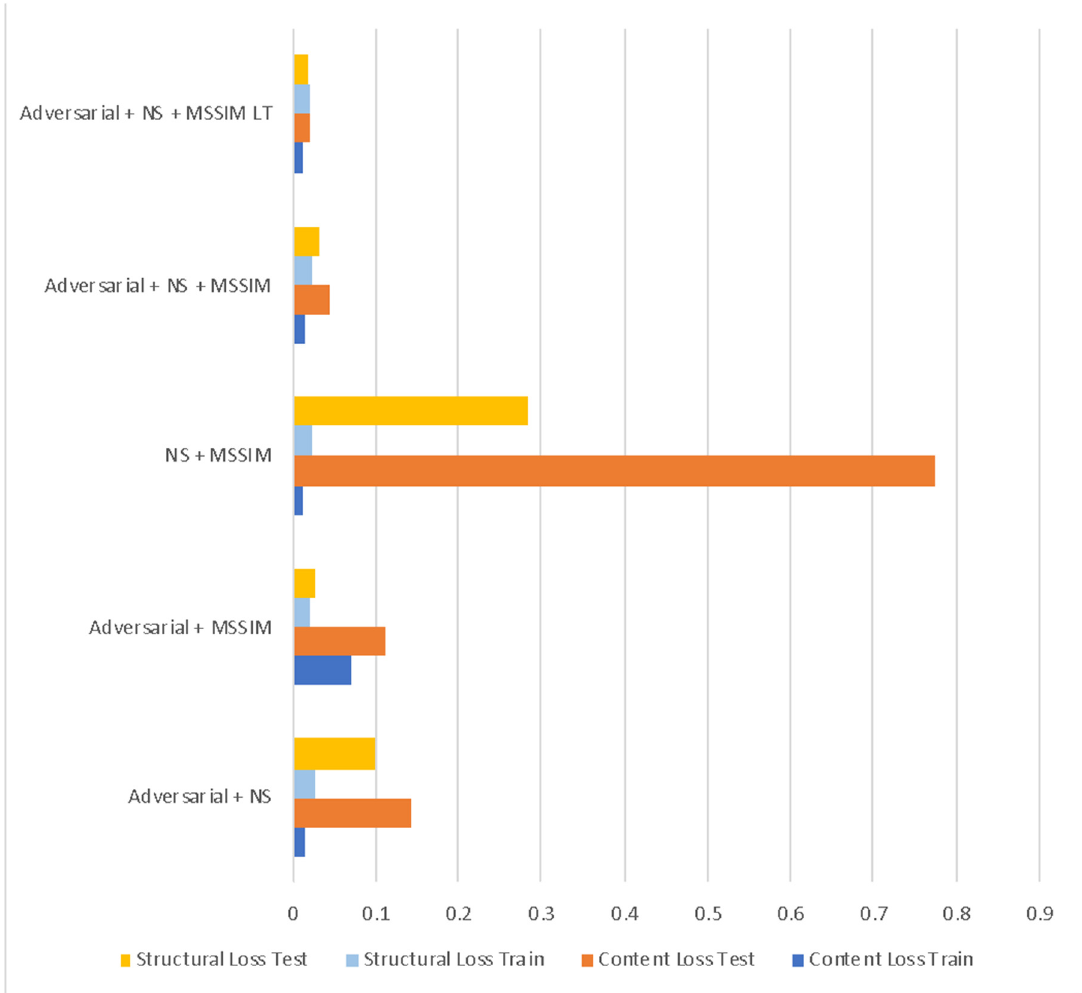
Figure 4. Different loss functions, used for training and their training and testing error. Figure 4. Di ff erent loss functions, used for training and their training and testing